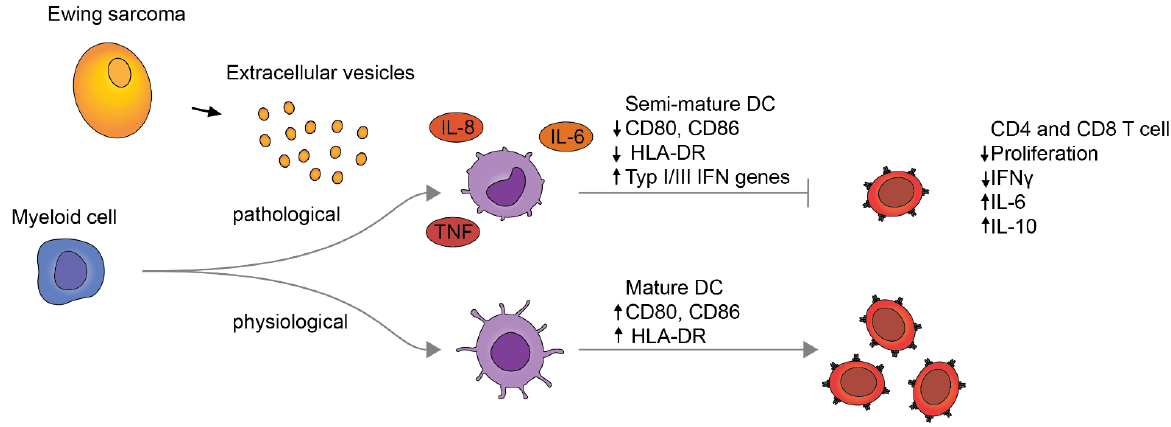
Figure 6. Proposed model for pathological activation of myeloid cells by EwS EVs.